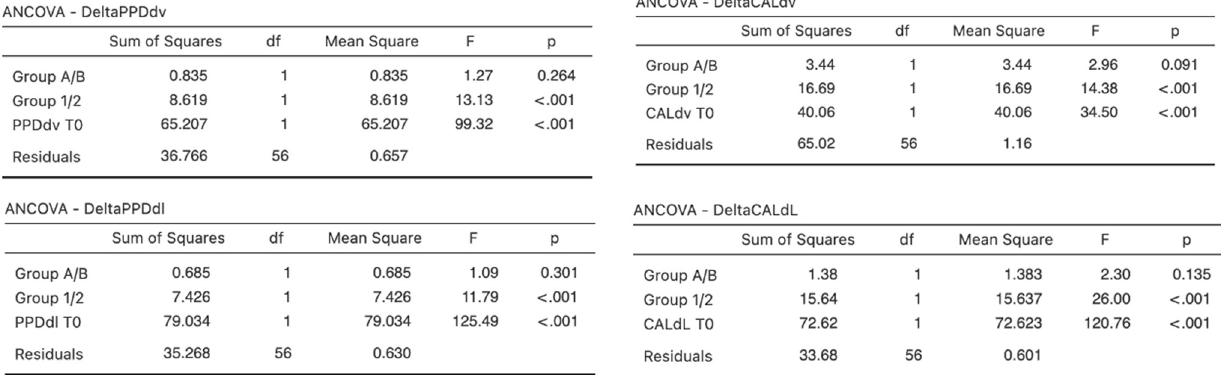
Figure 3. Between-group comparisons with ANCOVA: treatment type (A/B) as the independent variable; difference between preoperative and postoperative measurements as the dependent variable; covariables were age (1/2) and preoperative measurements. Legend: CALdv = CAL measurement at the disto-vestibular aspect of teeth; CALdl = CAL measurement at the disto-lingual aspect of teeth. PPDdv = PPD measurement at the disto-vestibular aspect of teeth; PPDdl = PPD measurement at the disto-lingual aspect of teeth; T 0 : preoperative measurements.